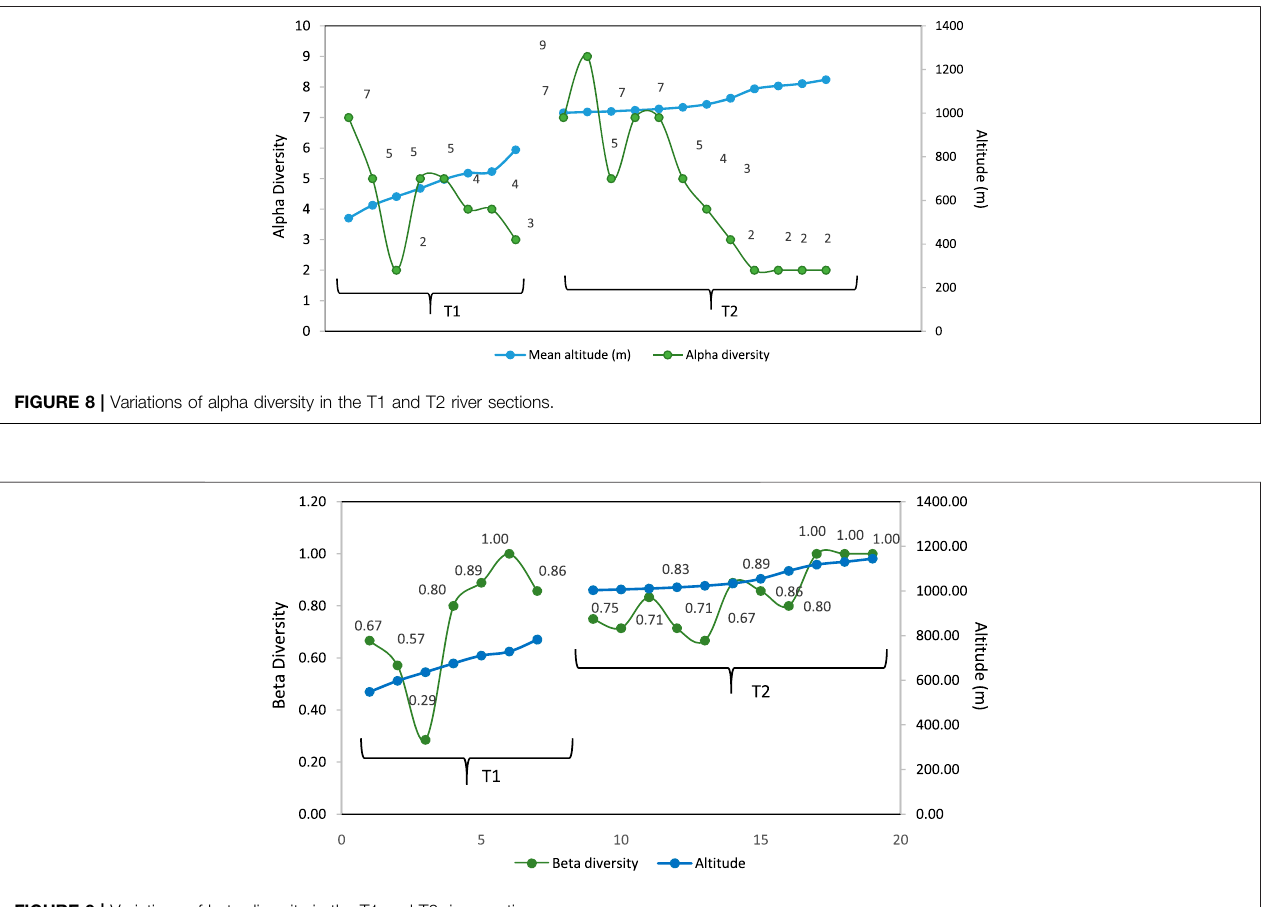
FIGURE 9 | Variations of beta diversity in the T1 and T2 river